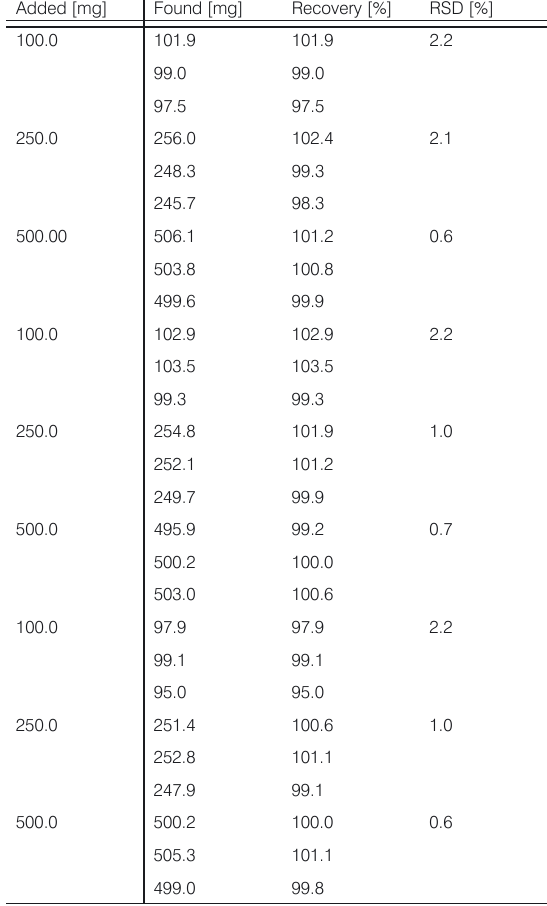
Table 6. Precision and accuracy of the potentiometric method over 3